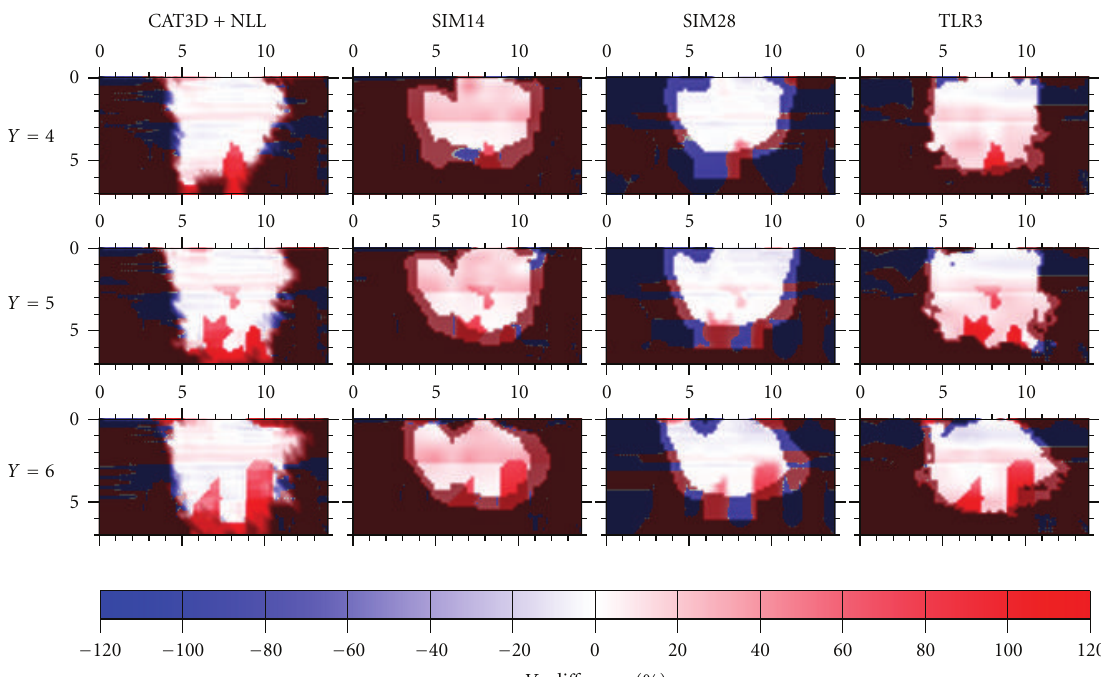
Figure 22: Di ff erence between the true and inverted V P fields. Blue/red areas indicate negative/positive misfit. White areas correspond to good fit. Three vertical EW sections at Y = 4,5,6 km are